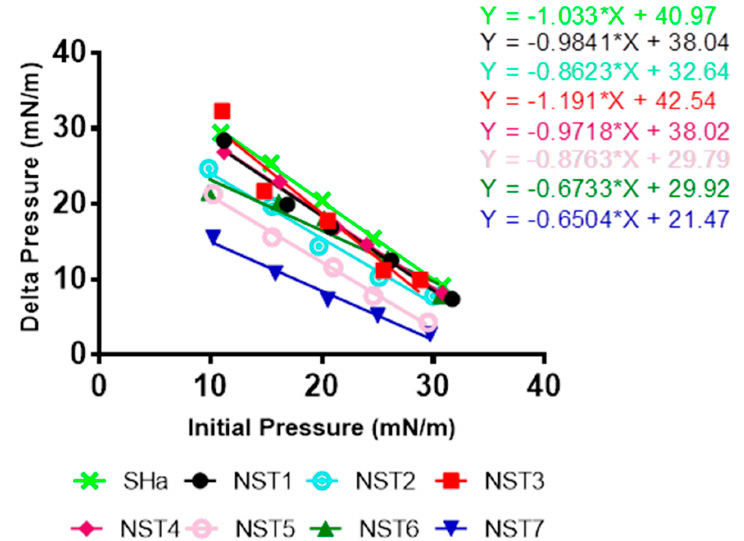
Figure 4. Measurement of the insertion of temporin-SHa and its analogs into total lipids of H. pylori . Insertion of temporin-SHa and its analogs into the total lipids of H. pylori (ATCC 43504) was studied as explained in Materials and Methods. Data are plotted as Delta Pressure (di ff erence between final and initial pressure) with respect to Initial pressure at injection of